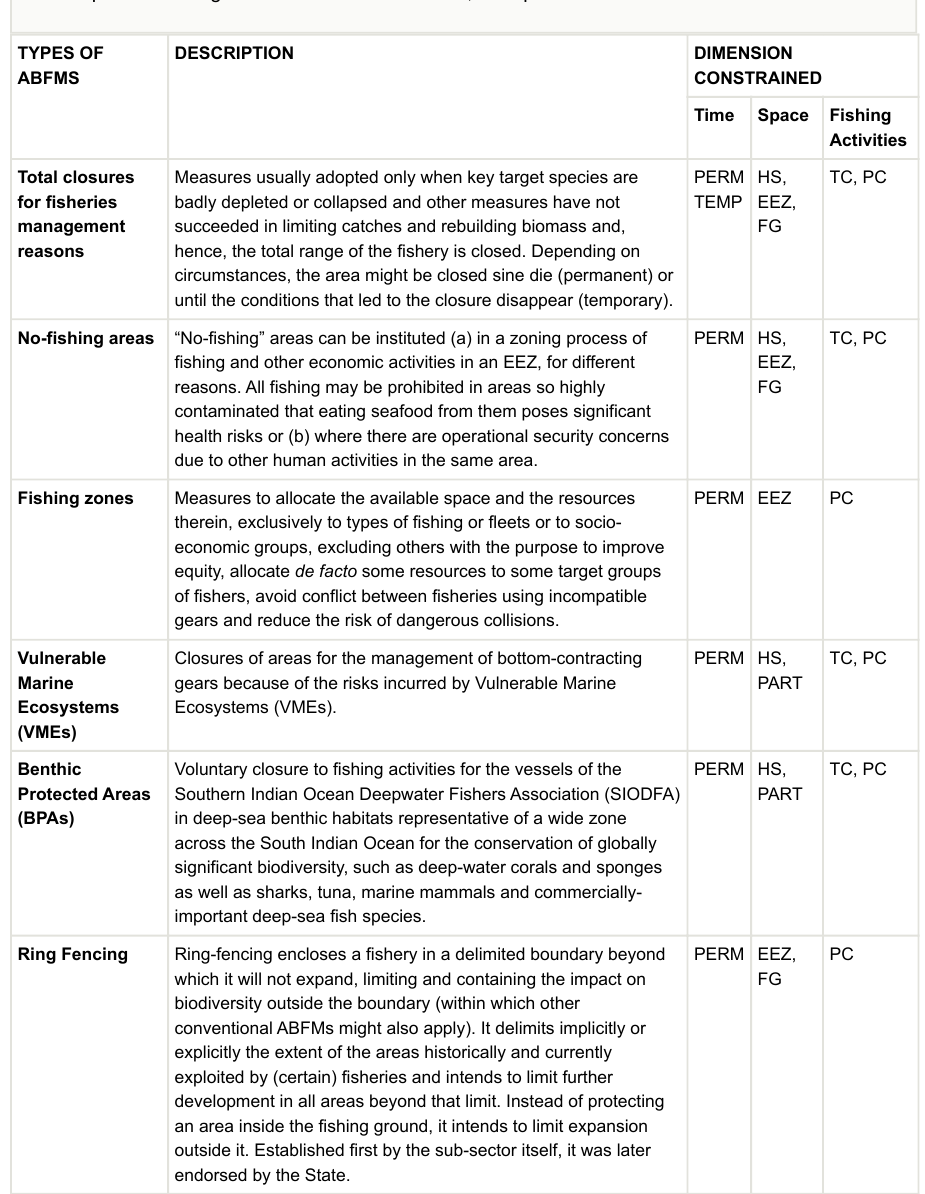
The contribution of Area-Based Fisheries Management Measures to Fisheries